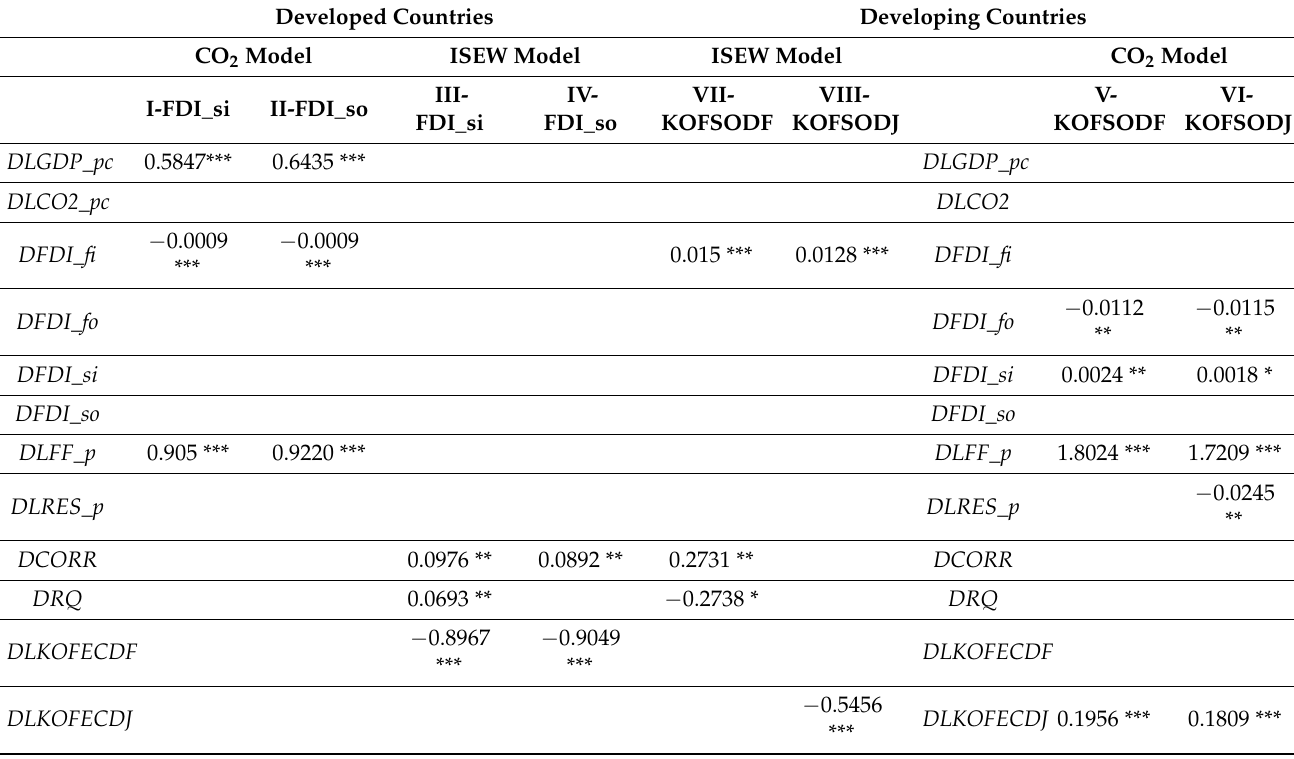
Table A3. Estimations of ARDL model—both models CO 2 and ISEW from 2000 to 2017. Developed